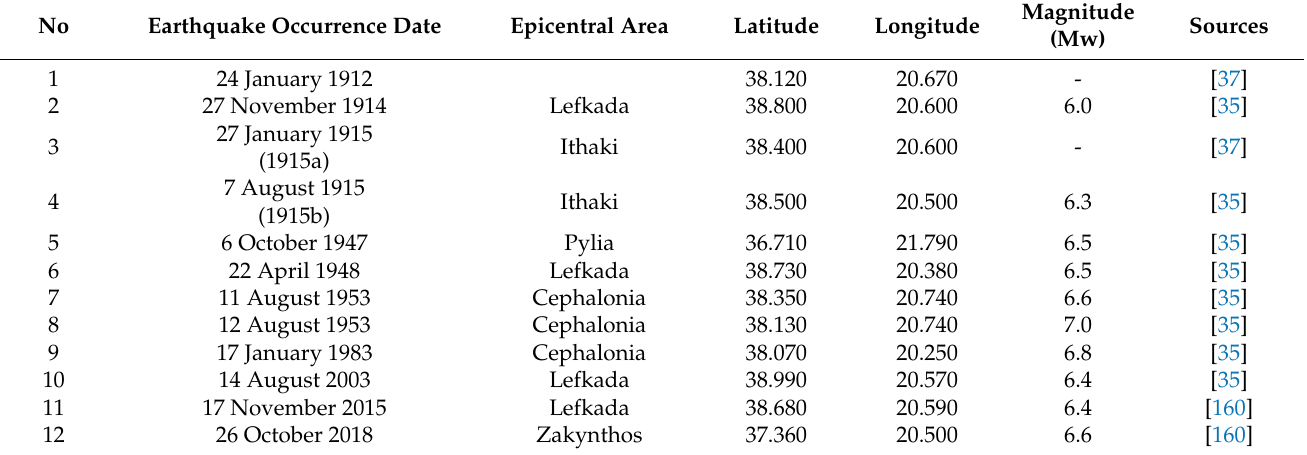
Table 2. Properties of the recent earthquakes (after 1900) that triggered sea disturbances including tsunamis in the Ionian Sea and the offshore western and southern